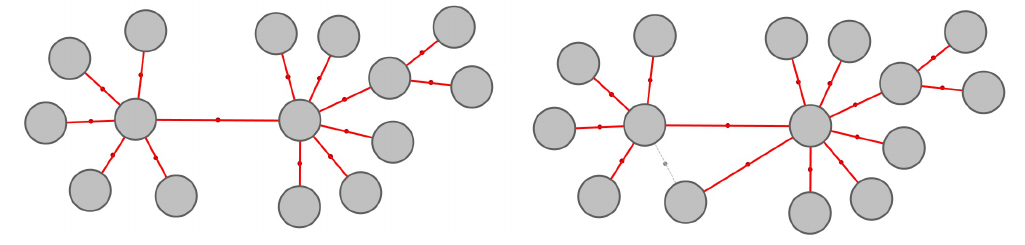
Figure 6: The resulted spanning trees from the original algorithm (left) and the modified algorithm